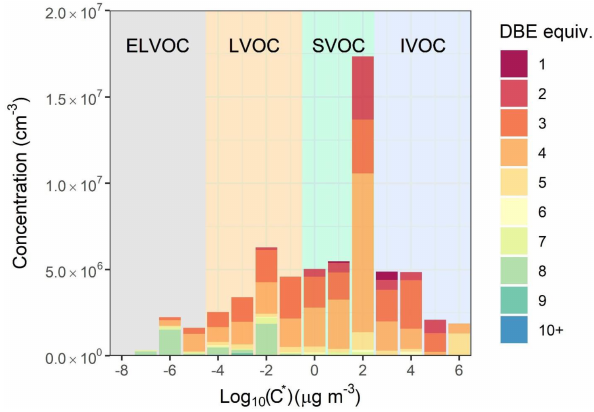
Figure 8. Concentrations of all oxygenated organic molecules and HOMs binned to integer log 10 (C ∗ ) values, coloured by